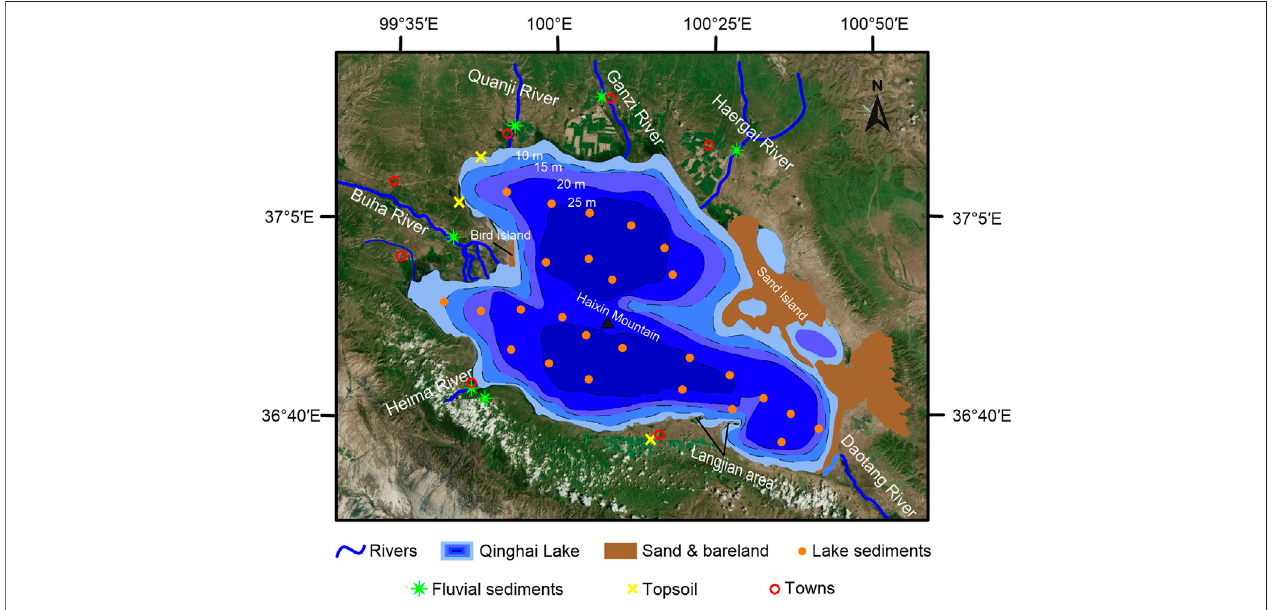
FIGURE 1 | Lake Qinghai Basin and sampling